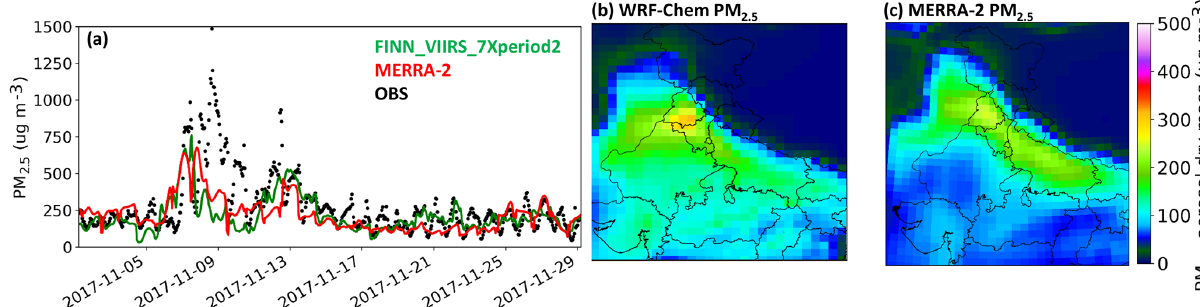
Figure 5. Temporospatial air quality performance of base scenario simulation: (a) time series of simulated (green line), MERRA-2 (red line), and ground measurement (black dots) hourly PM 2 . 5 concentration at US Embassy coordinates. (b, c) Hourly averaged PM 2 . 5 concentration maps of model regridded to MERRA-2 resolution (b) and MERRA-2 (c)